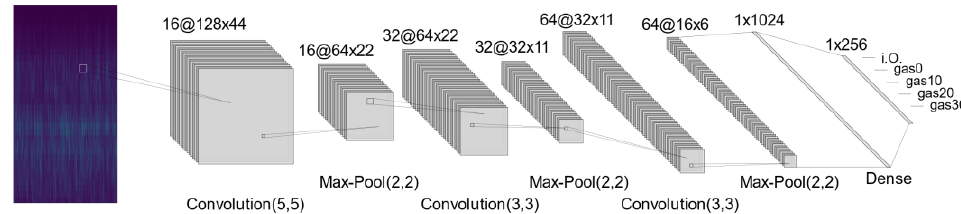
Figure 8. Structure of the chosen CNN with three convolutional layers in line with max-pooling layers and at least a dense neural network for classification.